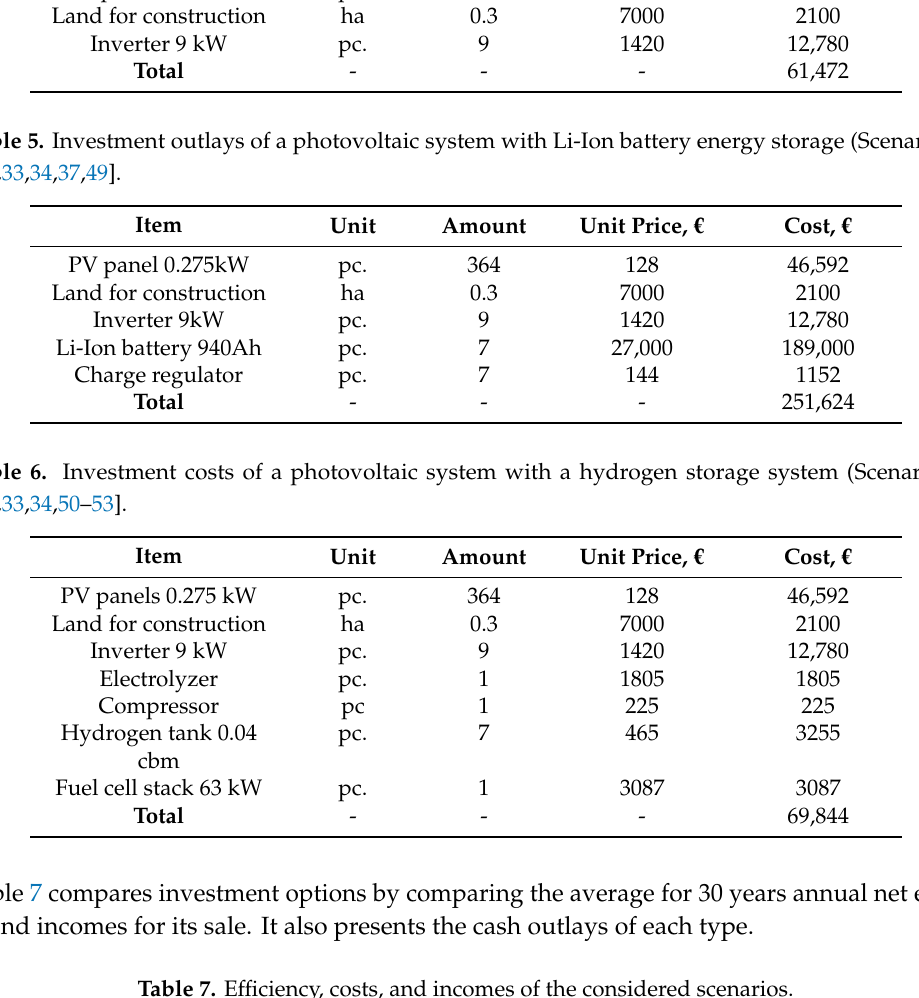
Table 4. Investment expenditure of PV array without energy storage (Scenario 1) [25,33,34].